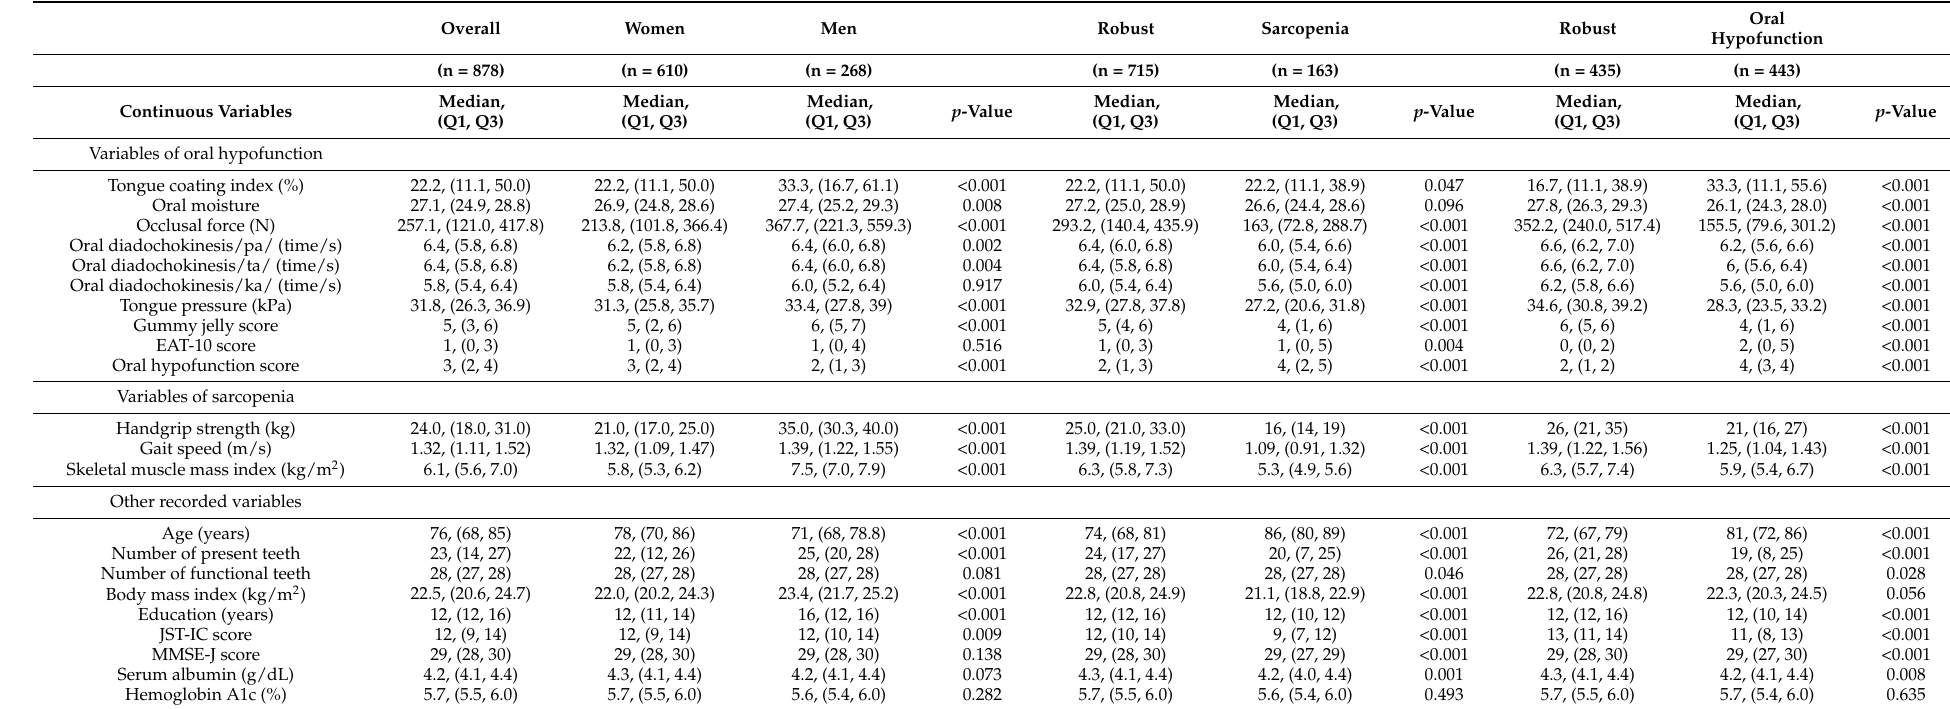
Table 1. Simple comparison of participant characteristics and continuous